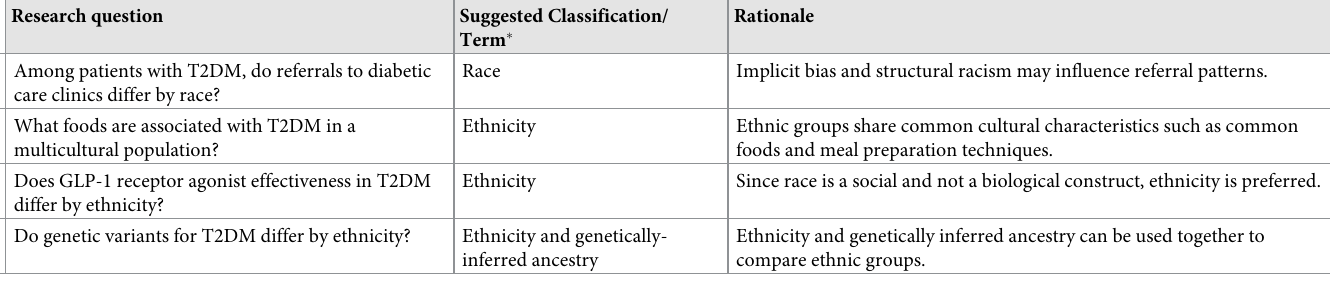
Table 1. Examples of type 2 diabetes mellitus (T2DM) questions and suggested classification/terms. Research